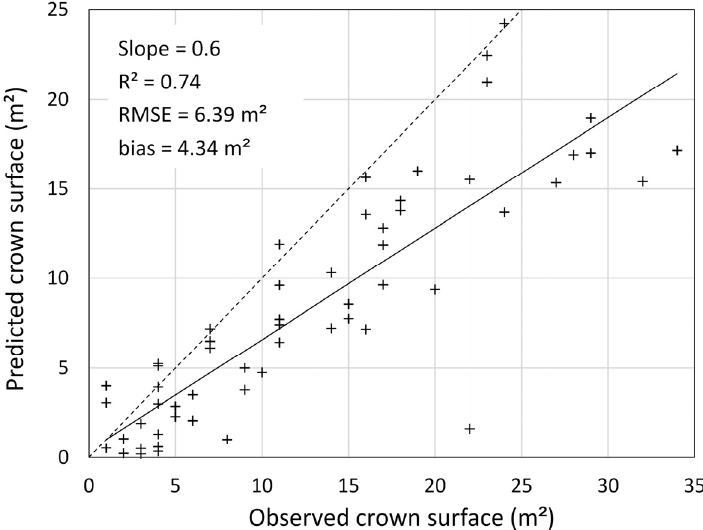
Figure 12. Linear regression between observed tree crown surfaces and predicted tree crown surfaces obtained from the 2D delineation method for the trees selected in the verification step.